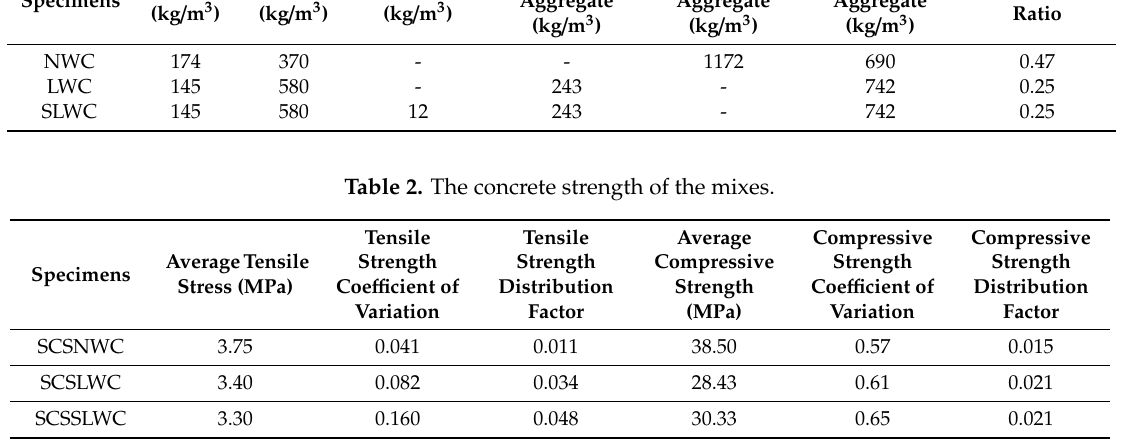
Table 2. The concrete strength of the mixes.